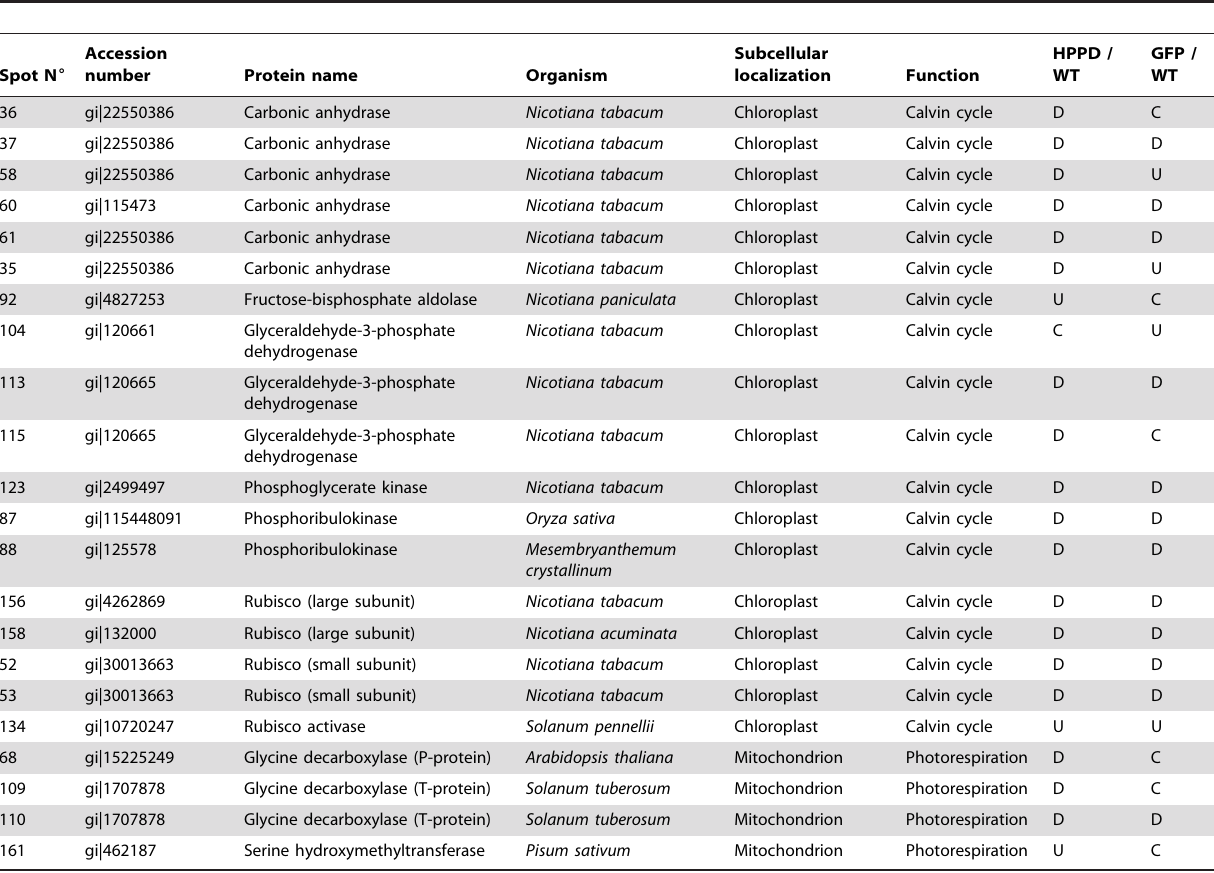
Table 1. Soluble varying proteins from tobacco leaf protein extracts identified by LC-MS/MS involved in CO 2